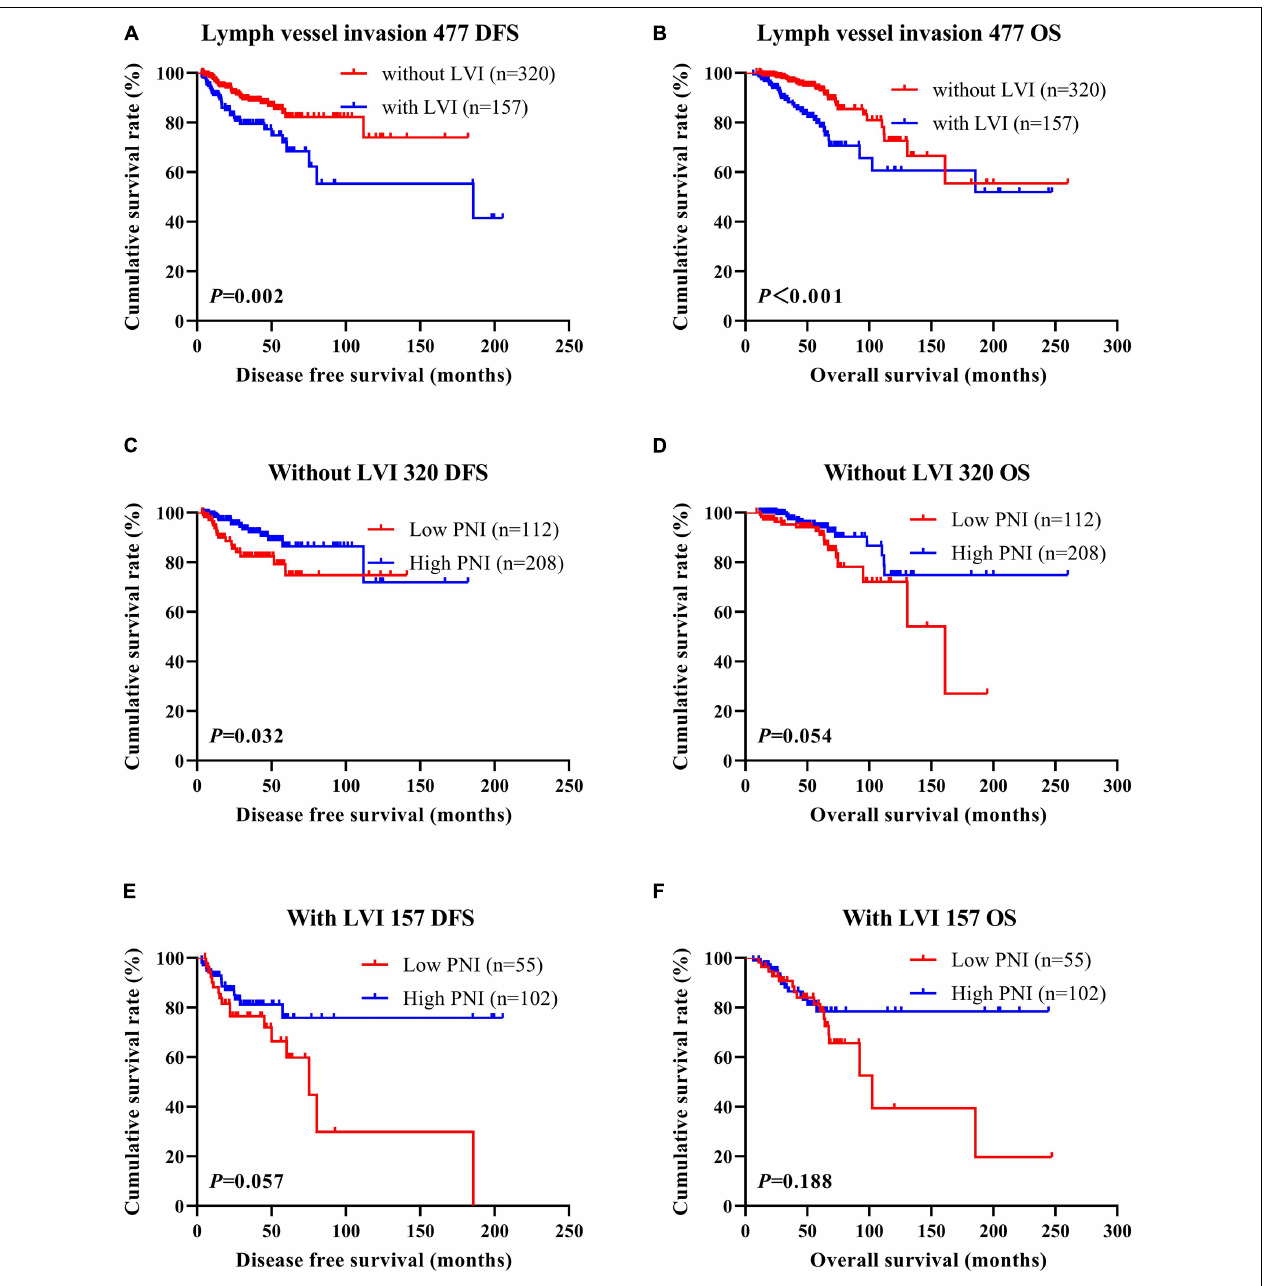
FIGURE 7 | Disease-free survival (DFS) and overall survival (OS) of patients with breast cancer by lymph vessel invasion status in the neoadjuvant chemotherapy (NACT) group. (A,B) Kaplan-Meier analysis of the DFS (A) and OS (B) of breast cancer patients by lymph vessel invasion status in NACT group. (C,D) Kaplan-Meier analysis of the DFS (C) and OS (D) of patients without lymph vessel invasion by prognostic nutritional index (PNI) in NACT group. (E,F) Kaplan-Meier analysis of the DFS (E) and OS (F) of patients with lymph vessel invasion by PNI in NACT